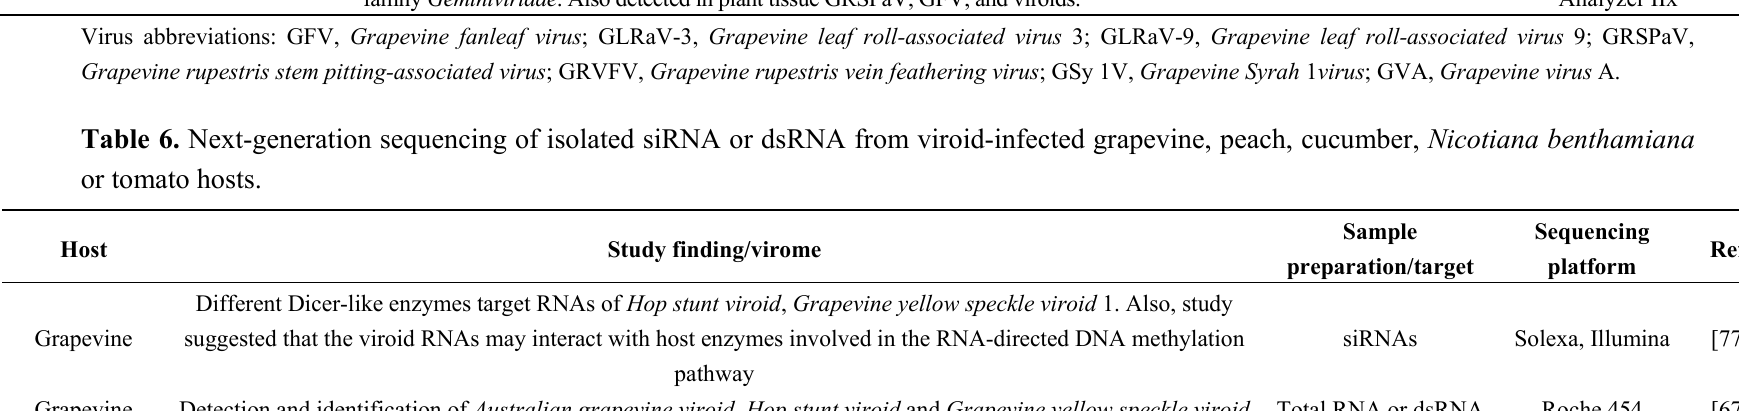
A novel species of virus was discovered for which the provisional name Grapevine Pinot gris virus is proposed. Also, Grapevine detected and identified GRSPaV, GRVFV, GSy 1V, and viroids. A novel circular DNA virus was identified associated with red blotch disease in grapevine in California. A provisional Grapevine name of Grapevine red blotch-associated virus is proposed for the novel virus. Grapevine A novel Vitivirus was identified. The virus is provisionally named Grapevine virus F. Grapevine Characterization of siRNAs associated with grapevine leafroll disease. Complete sequence of a novel single-stranded DNA virus associated with grapevine red leaf disease (GRD). The virus is Grapevine tentatively named Grapevine red leaf-associated virus (GRLaV). The virus represents an evolutionary distinct lineage in the family Geminiviridae . Also detected in plant tissue GRSPaV, GFV, and viroids.